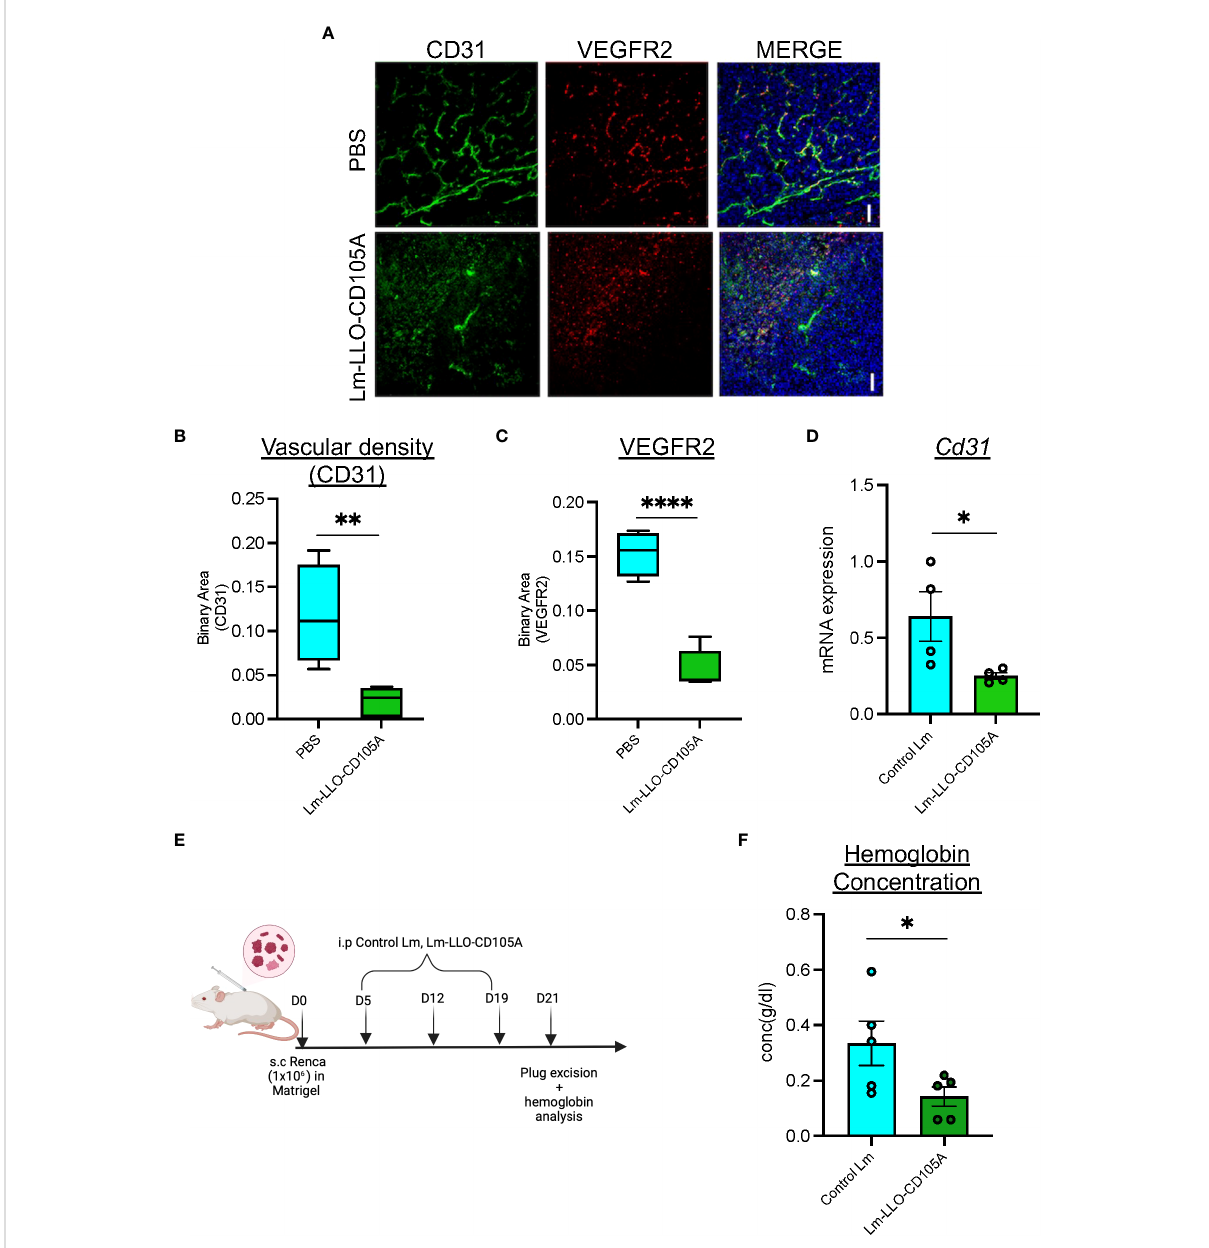
FIGURE 3 Lm-LLO-CD105 controls tumor angiogenesis. (A) Representative images of immuno fl uorescence-stained sections of PBS control tumors and Lm- LLO-CD105A vaccinated tumor. Slides were stained with antibodies against VEGFR2 and CD31. Scale bar 50um. (B) Quantitative vascular density (CD31) of immuno fl uorescence-stained sections. (C) Quanti fi cation of VEGFR2 stained immuno fl uorescence sections (D) Relative mRNA expression of CD31 between Control Lm and Lm-LLO-CD105 treated tumors. (E) Experimental schema for hemoglobin assay (F) Hemoglobin quanti fi cation in tumor tissues of Control Lm and Lm-LLO-CD105 vaccine treated tumors. (n=4-5/group) Data were analyzed using unpaired t-test. *P < 0.05, **P < 0.01, **** P<0.0001 . All error bars are shown as mean ± SEM. Experimental schema was made in